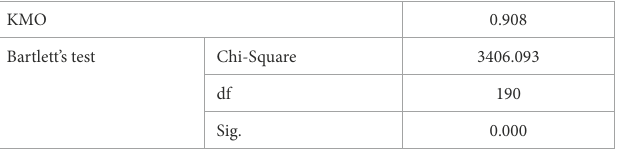
TABLE 3 KMO and Bartlett’s test.